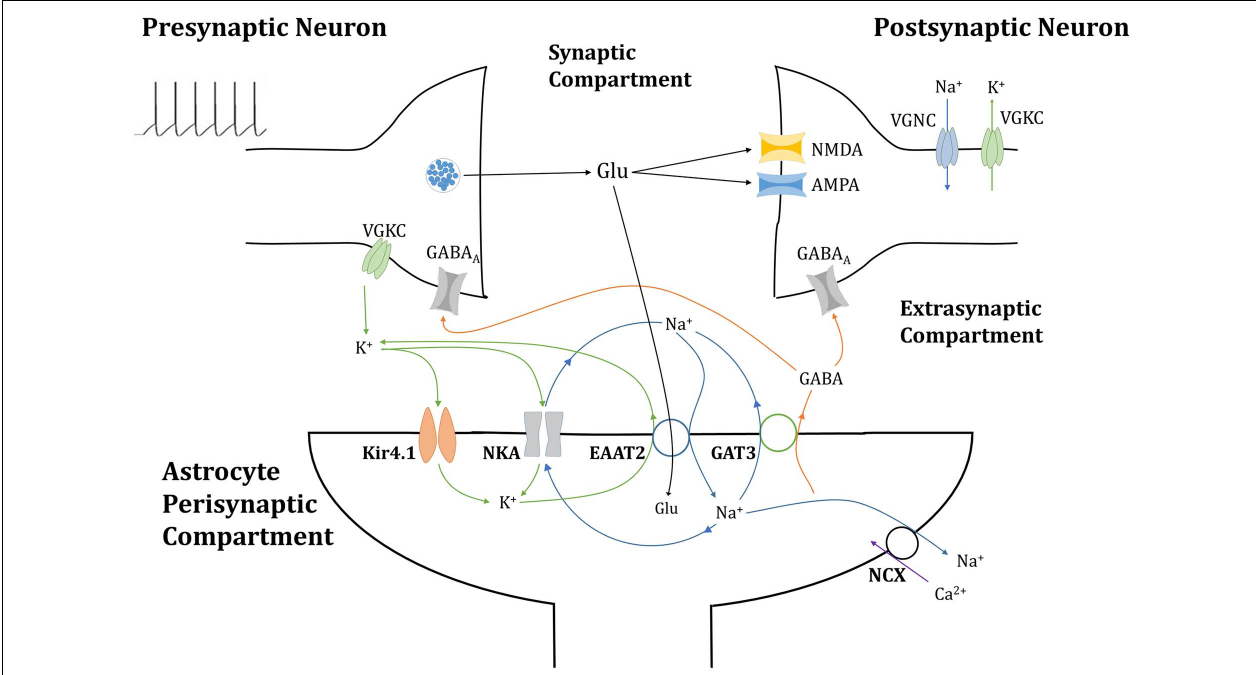
FIGURE 1 | Tripartite glutamatergic synapse compartment model: consisting of neuronal, synaptic, and astrocytic compartments, within which ionic concentrations are dynamic and neuronal membrane currents respond to neurotransmitter-mediated ionotropic currents (not to scale). Glutamate (Glu) neurotransmitter is released into the synapse by the presynaptic neuron in a membrane potential-dependent mechanism, where it activates neurotransmitter-gated ionotropic receptors NMDA and AMPA channels located on the postsynaptic neuron. This postsynaptic membrane activity triggers the activation of voltage-gated sodium (Na + ) and potassium (K + ) channels (VGNC and VGKC, respectively), also located on the postsynaptic neuronal membrane. Synaptic Glu is exclusively taken up by astrocytic membrane-bound excitatory amino acid transporter 2 (EAAT2), along with synaptic Na + and the counter-transport of astrocytic K + . The influx of Na + into the astrocytic compartment triggers the release of GABA (and Na + ) through GABA transporter type 3 (GAT3), into the synaptic compartment, where it activated inhibitory ionotropic GABA A receptors located both on the pre- and postsynaptic neuronal membranes. Synaptic K + transport is completed with the inclusion of inwardly rectifying K + channels (Kir4.1) and the Na + /K + ATPase transporter (NKA). Na + dynamics are completed by the NKA and reversible Na + /Ca 2 + exchanger